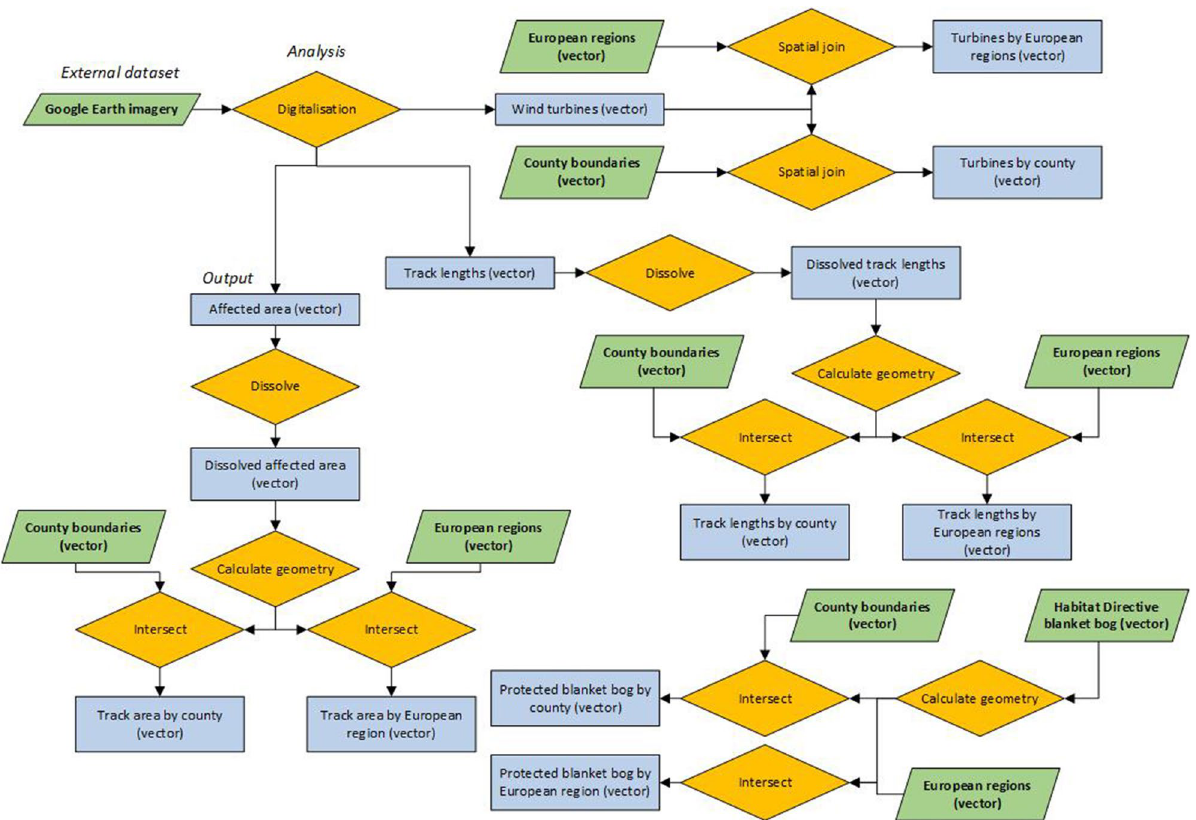
Figure 6. Flowchart of spatial analyses undertook in this research to obtain the final products using ArcGIS 10.8.1 and QGIS.